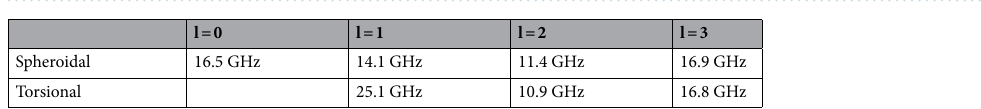
Table 1. Eigenfrequencies of the quartz globules forming a synthetic opal matrix.